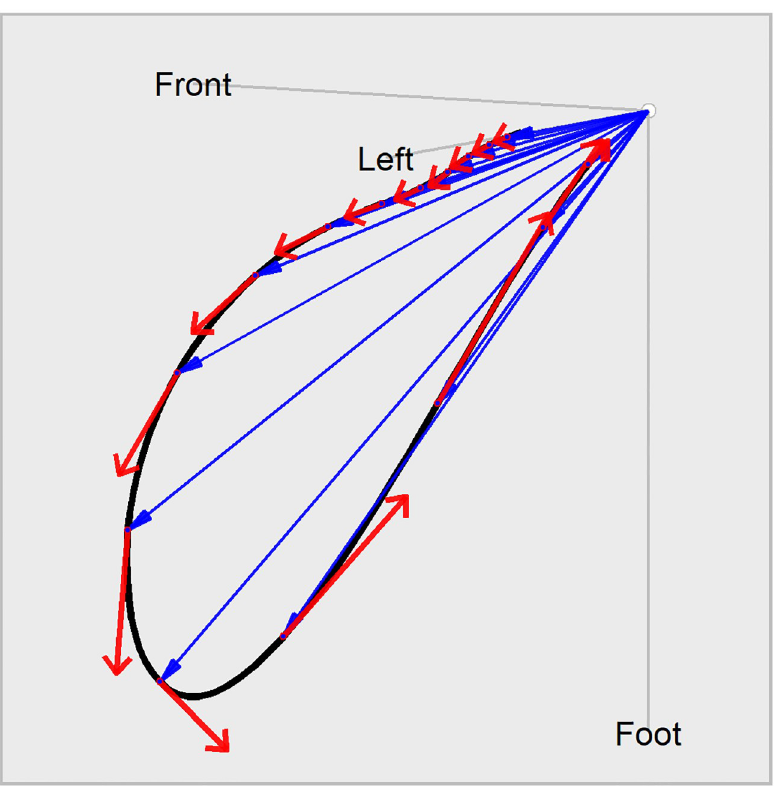
Fig 1. Derivation of the TVV from the T vector loop. Displayed is the time course of the heart vector in 20 ms steps (blue arrows), forming the 3-dimensional T vector loop (black curve). The red arrows indicate the TVV, the velocity at which the heart vector is moving at the given